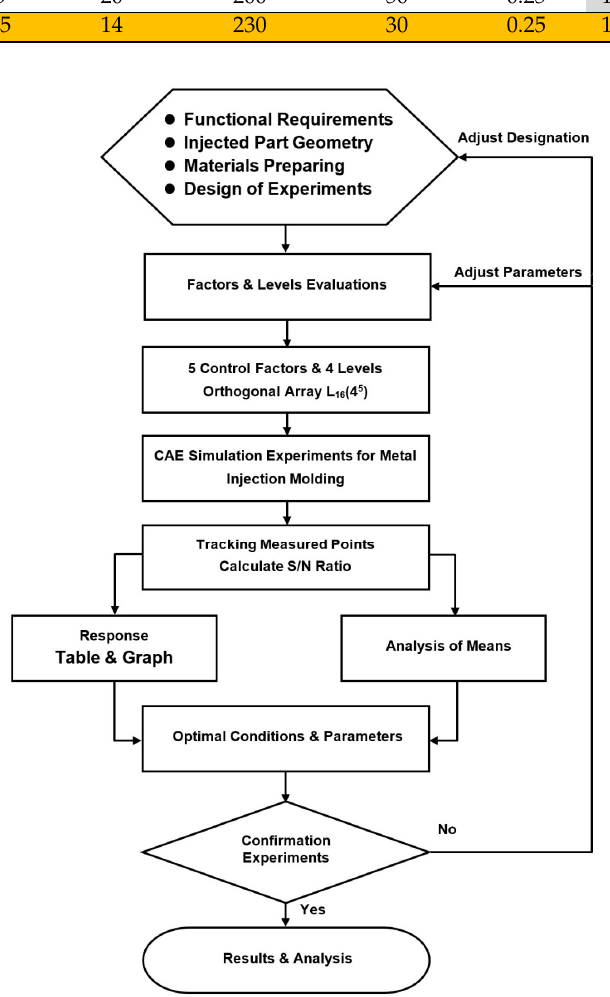
Figure 6. Flow chart of Taguchi-based MIM simulation framework. S/N: signal-to-noise.